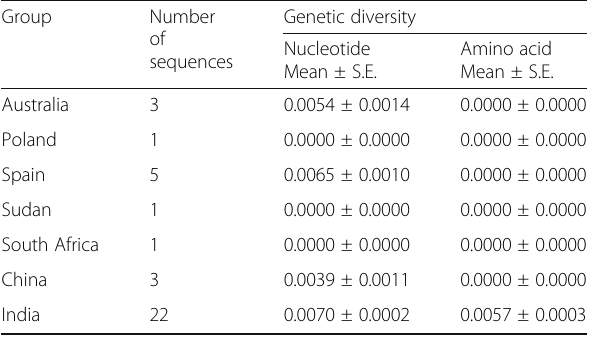
Table 4 Pairwise genetic diversity of groups of HearNPV isolates from different continents Group Number Genetic diversity of Nucleotide sequences Mean ±